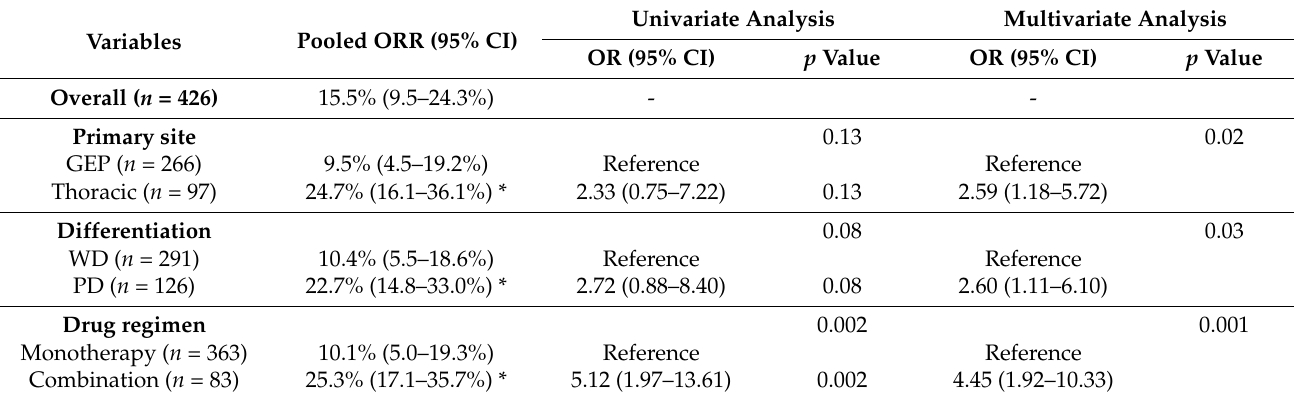
Table 2. Meta-regression analysis of the overall response rate.